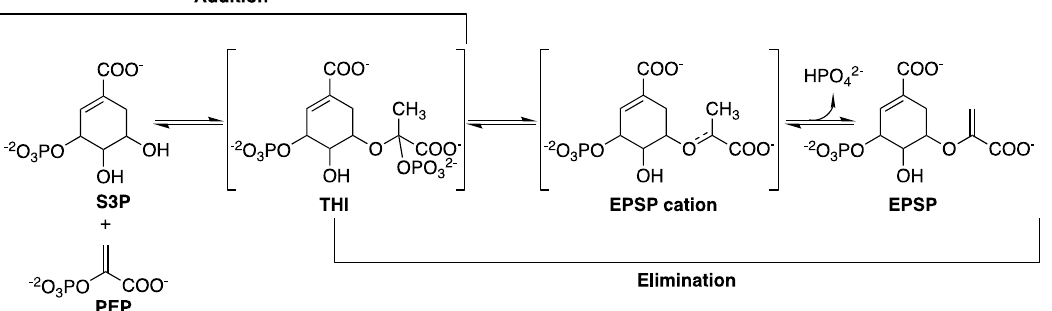
Figure 15. General reaction of EPSPS with the particular tetrahedral intermediate.